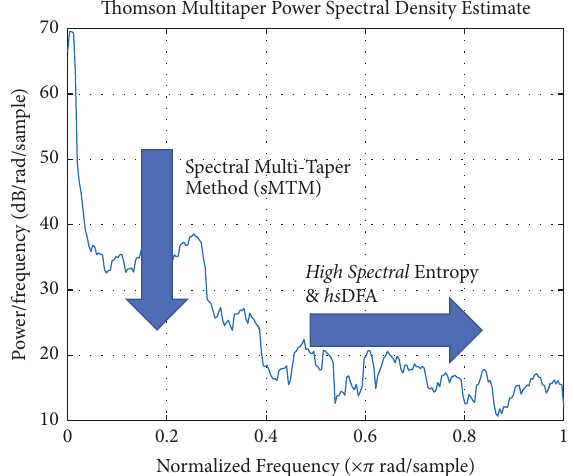
Figure 2: A MTM power spectrum of a time series of 500 RR intervals in a traffic noise exposure subject. sMTM is the area beneath the spectrum, yet above the baseline created by broadband noise as the signal becomes chaotic. High spectral entropy and high spectral DFA are derived by applying the Shannon entropy and detrended fluctuation analysis (DFA) functions to the MTM power spectrum. Parameters for the MTM power spectra as set at (i) sampling frequency of 1Hz, (ii) time bandwidth for the DPSS at 3, (iii) FFT length of 256, and (iv) Thomson’s “adaptive” nonlinear combination method to combine individual spectral